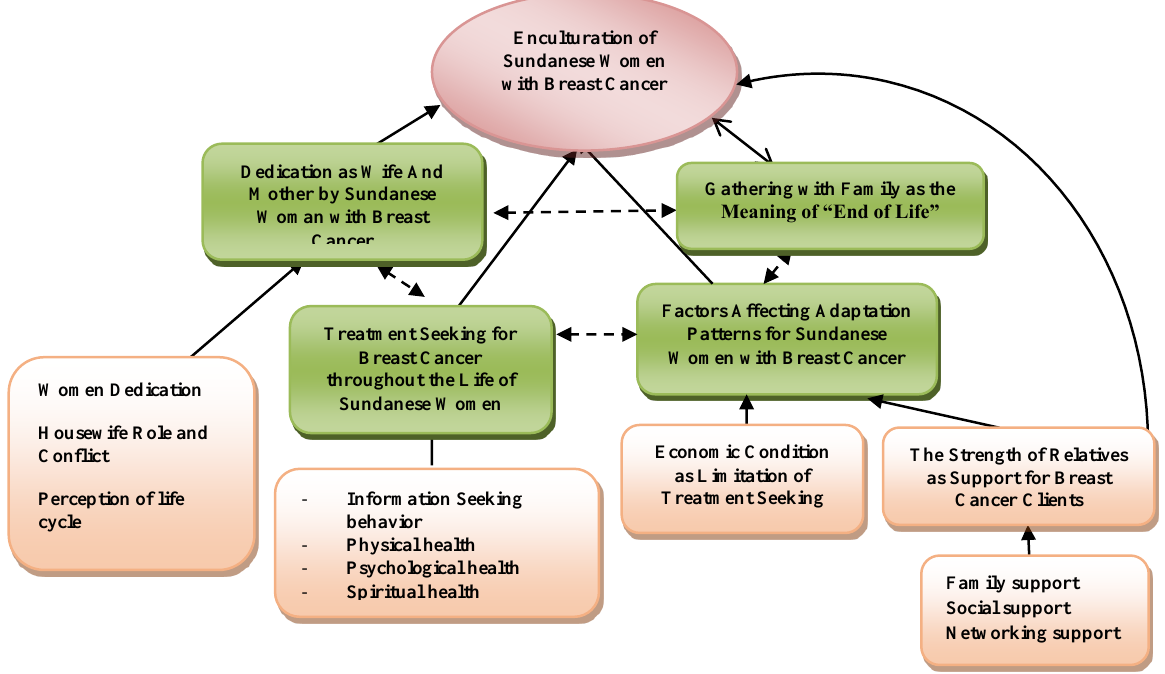
Diagram 2. Life Pattern of Breast Cancer